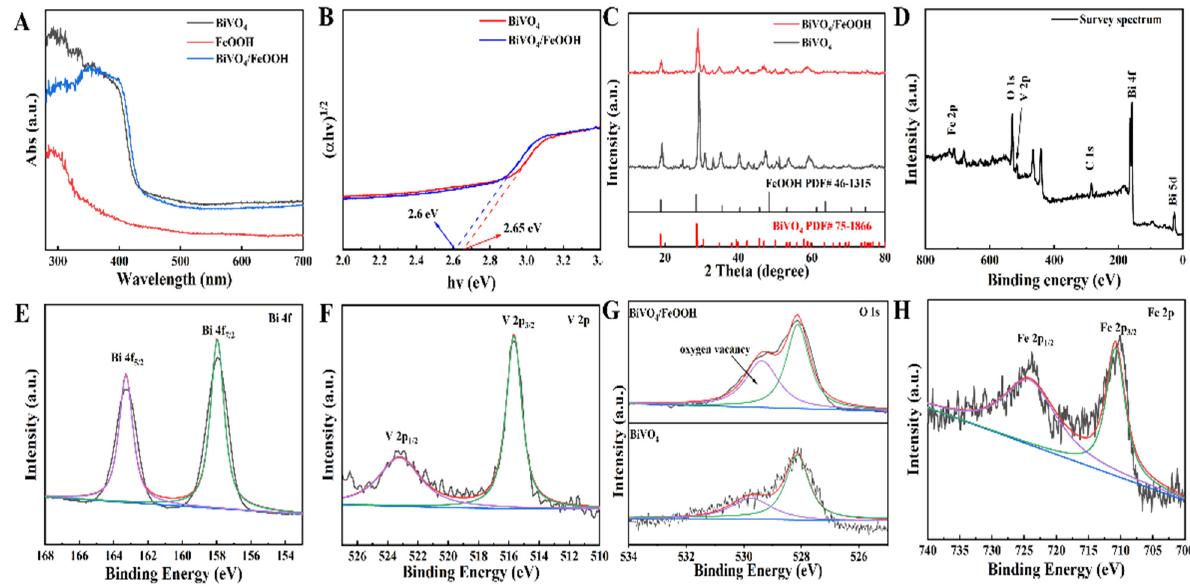
Figure 3. ( A ) UV-vis absorption spectrum of BiVO 4 , FeOOH, and BiVO 4 /FeOOH. ( B ) The corre- sponding Tauc plots of ( A ). ( C ) XRD patterns of BiVO 4 , FeOOH, and BiVO 4 /FeOOH. ( D – H ) XPS spectrum of the BiVO 4 /FeOOH nanocomposite.